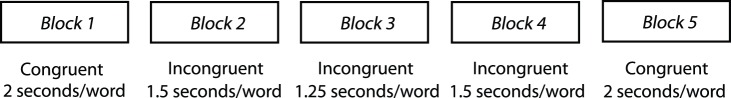
Structure of the Stroop Color-Word Interference Task.The duration of each block is one minute.